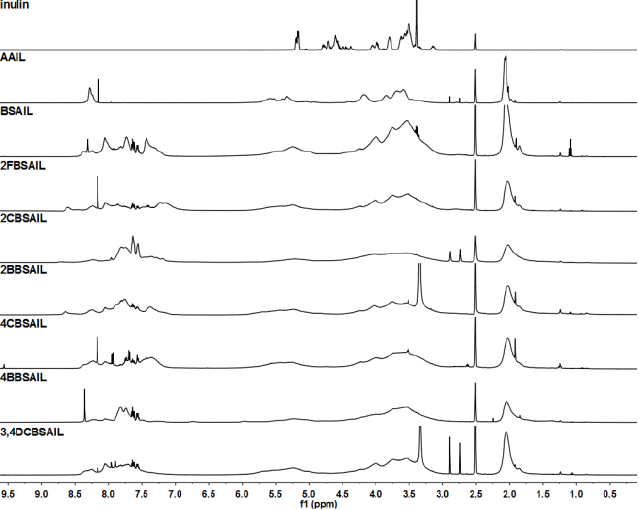
Figure 2. 1 H NMR spectra of inulin, AAIL, and inulin derivatives, recorded in DMSO-d6.